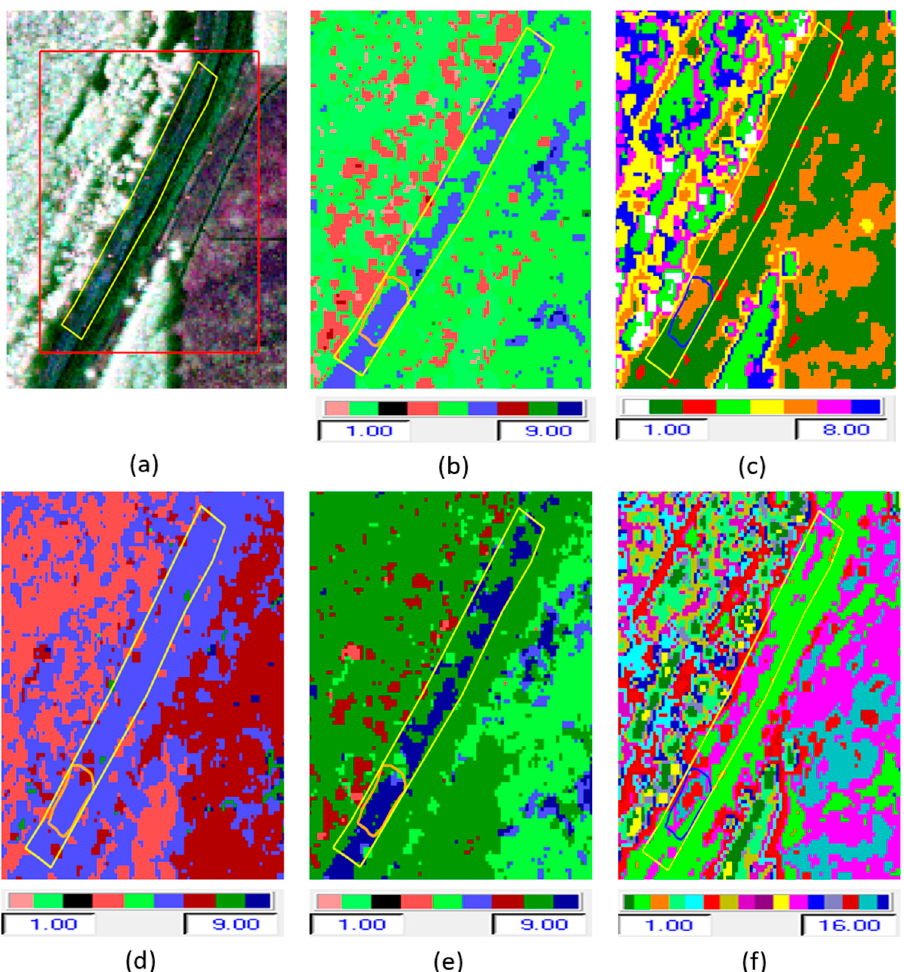
Figure 6. ( a – c ) Pauli RGB Image, H/ α classification, and Wishart-H/ α classification; ( d – f ) H/A classification, A/ α classification, and Wishart-H/A/ α classification. Sensors 2016 , 16 , 898